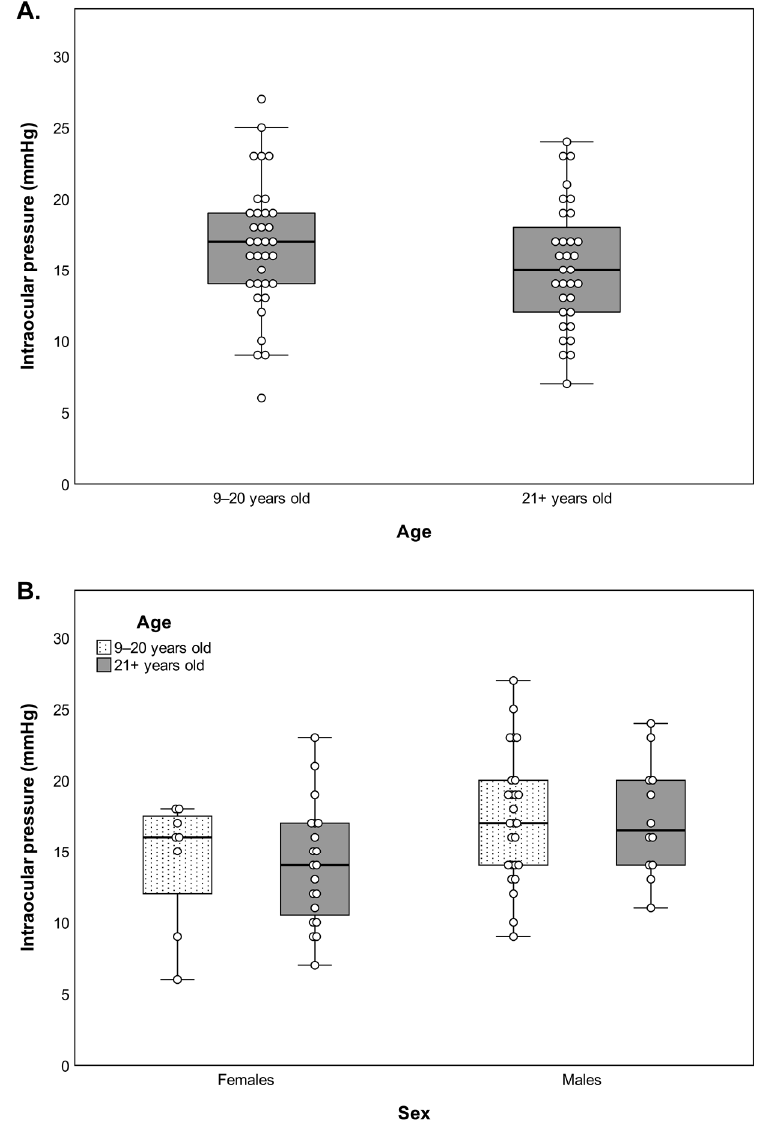
Figure 1. Distribution of the intraocular pressure in the tested monkeys by age ( A ) and by age and sex ( B ). No significant differences are found for any of the comparisons.